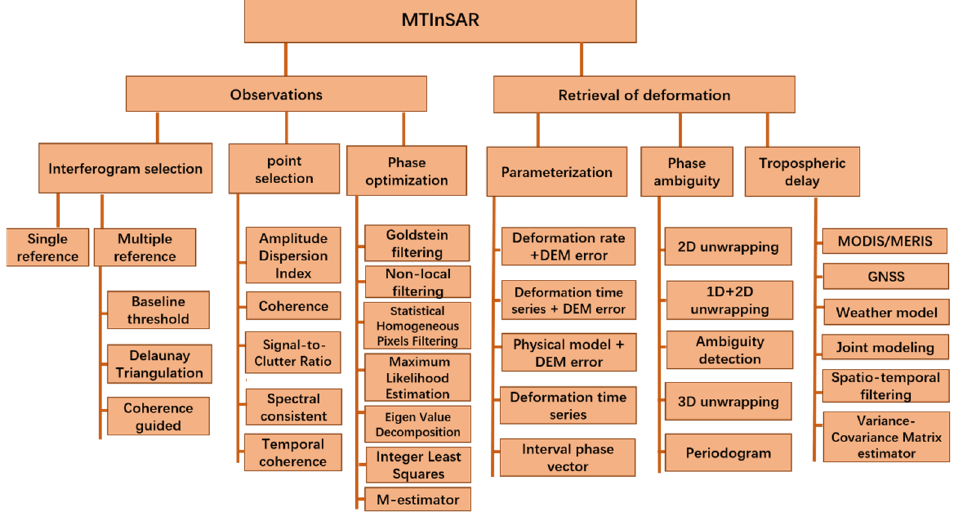
Figure 1. The technical framework of MTInSAR.